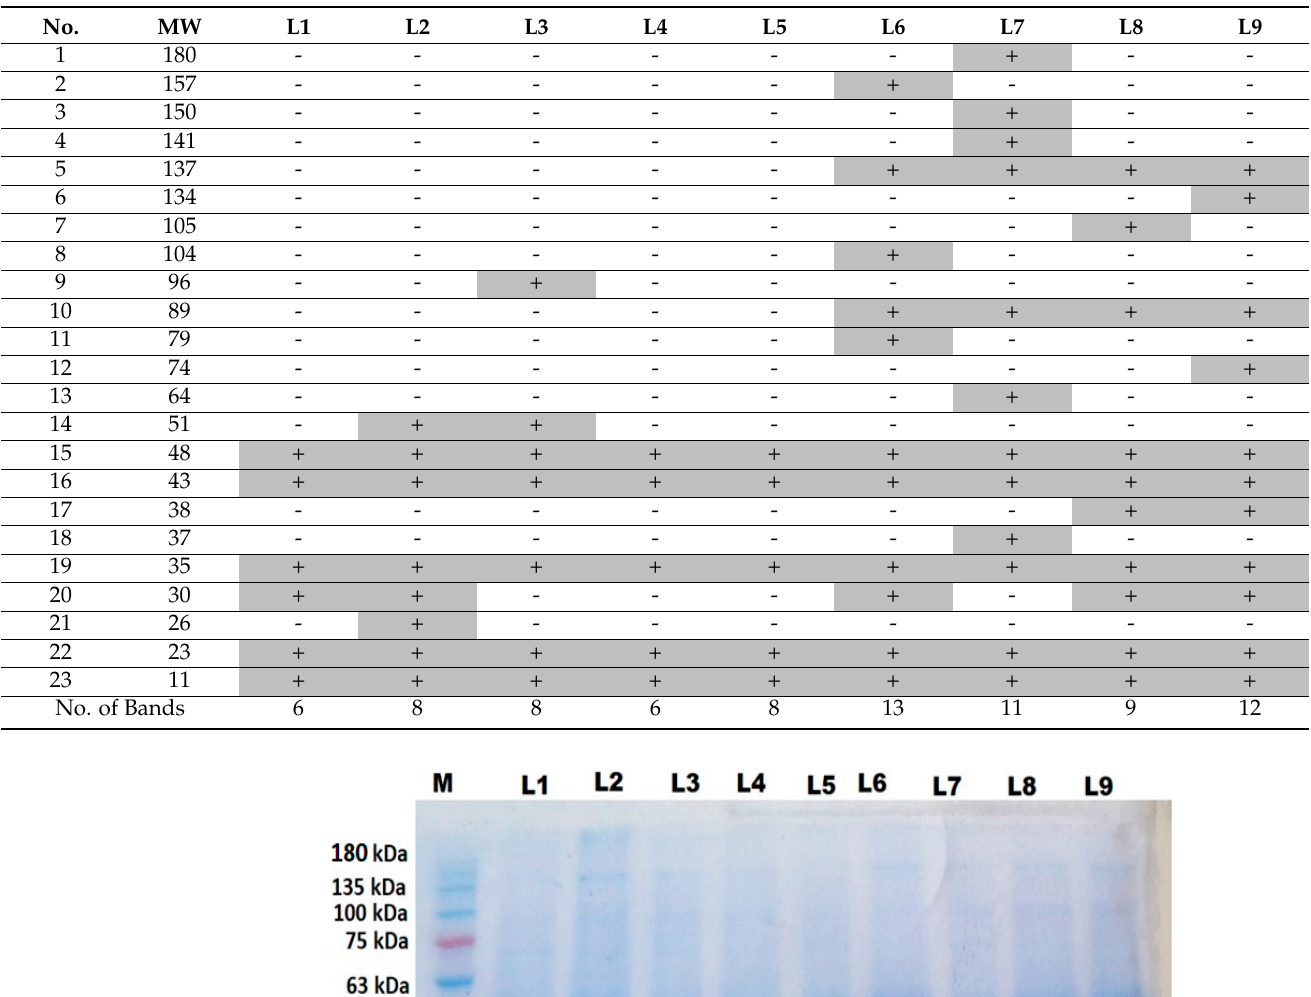
Table 2. Changes in protein profile in leaves of wheat plants originated from irradiated grains and treated with stigmasterol. L1: Control, L2: 25 Gy, L3: 50 Gy, L4: 100 ppm stigmasterol, L5: 25 Gy +